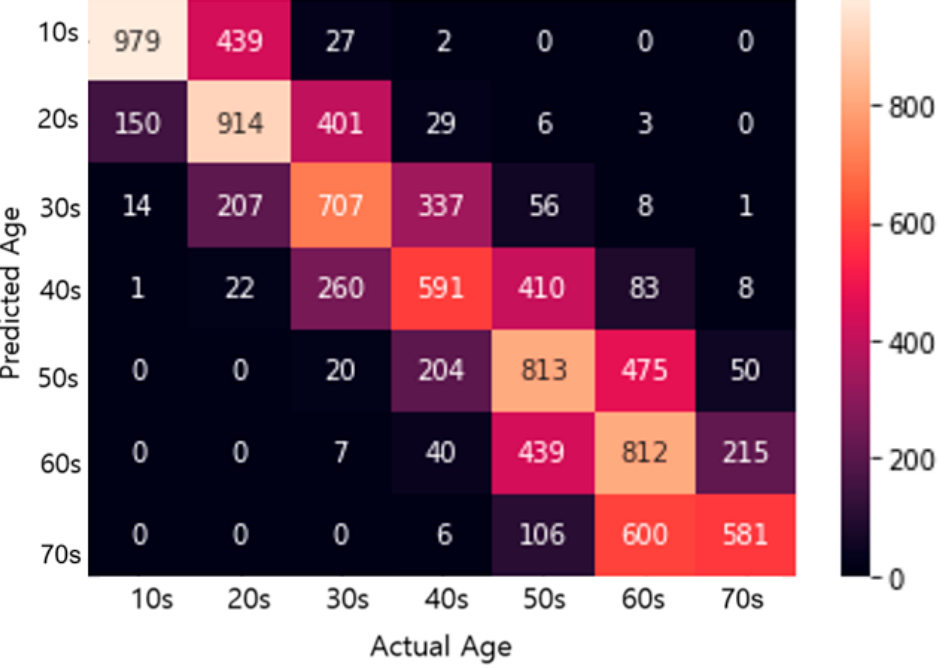
Figure 7. Confusion matrix with actual and predicted ages.